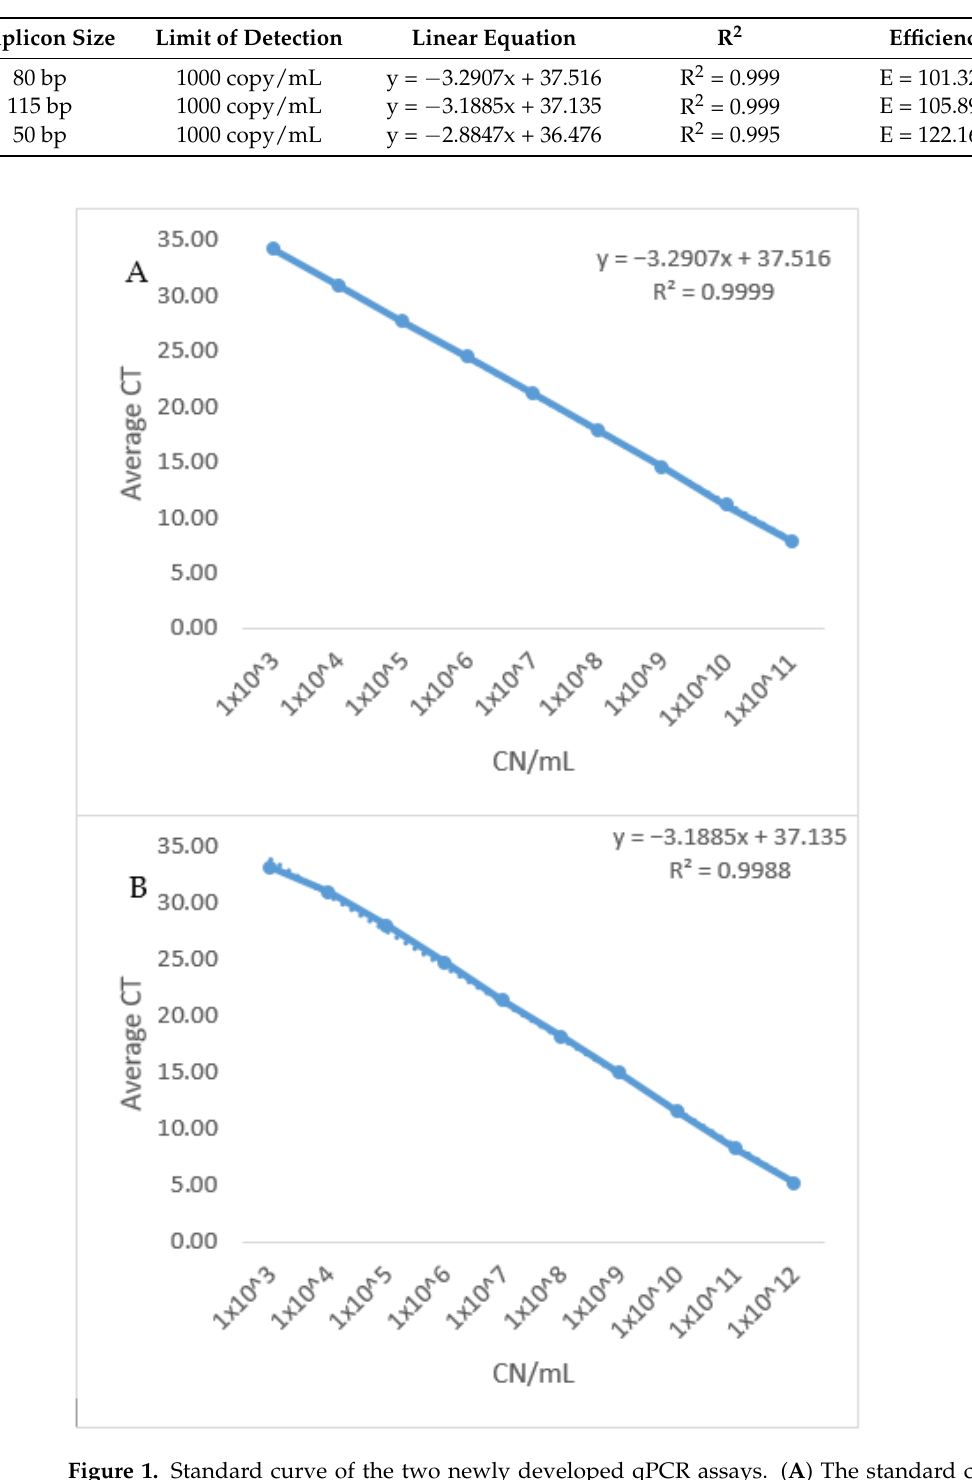
Figure 1. Standard curve of the two newly developed qPCR assays. ( A ) The standard curve of BA BAV1945 qPCR assay was generated by plotting average CT values from three independent runs against log10 of 10 fold serial dilutions (from 10 11 –10 3 ) of plasmid DNA (copy number/mL). Reaction efficiency of 101.3% was estimated using the standard curve slope. ( B ): Standard curve of BA fhaC qPCR assay was generated by plotting average CT values from three independent runs against log10 of 10 fold serial dilutions (10 11 –10 3 ) of plasmid DNA (copy number/mL). Reaction efficiency of 105.89% was estimated using the standard curve slope.